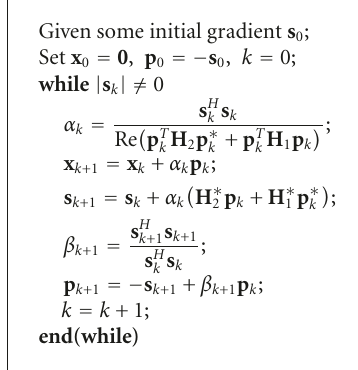
Algorithm 1: Complex conjugate gradient algorithm.